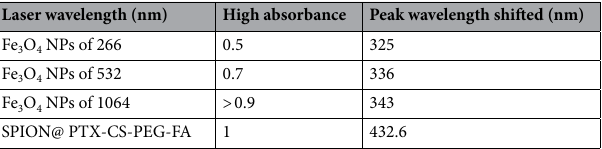
Table 4. Laser wavelengths and high peak shifts of SPION at 28 J/cm 2 in KMnO 4 solution.